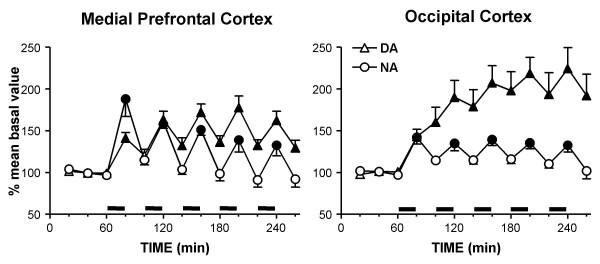
Effect of repeated locus coeruleus stimulation on extracellular NA and DA levels in the medial prefrontal and occipital cortex. Stimuli were delivered in bursts, as described in Methods (horizontal solid lines). Data are means ± SE, expressed as percent of mean basal value. Filled symbols indicate p < 0.05 with respect to basal values (Dunnett test).